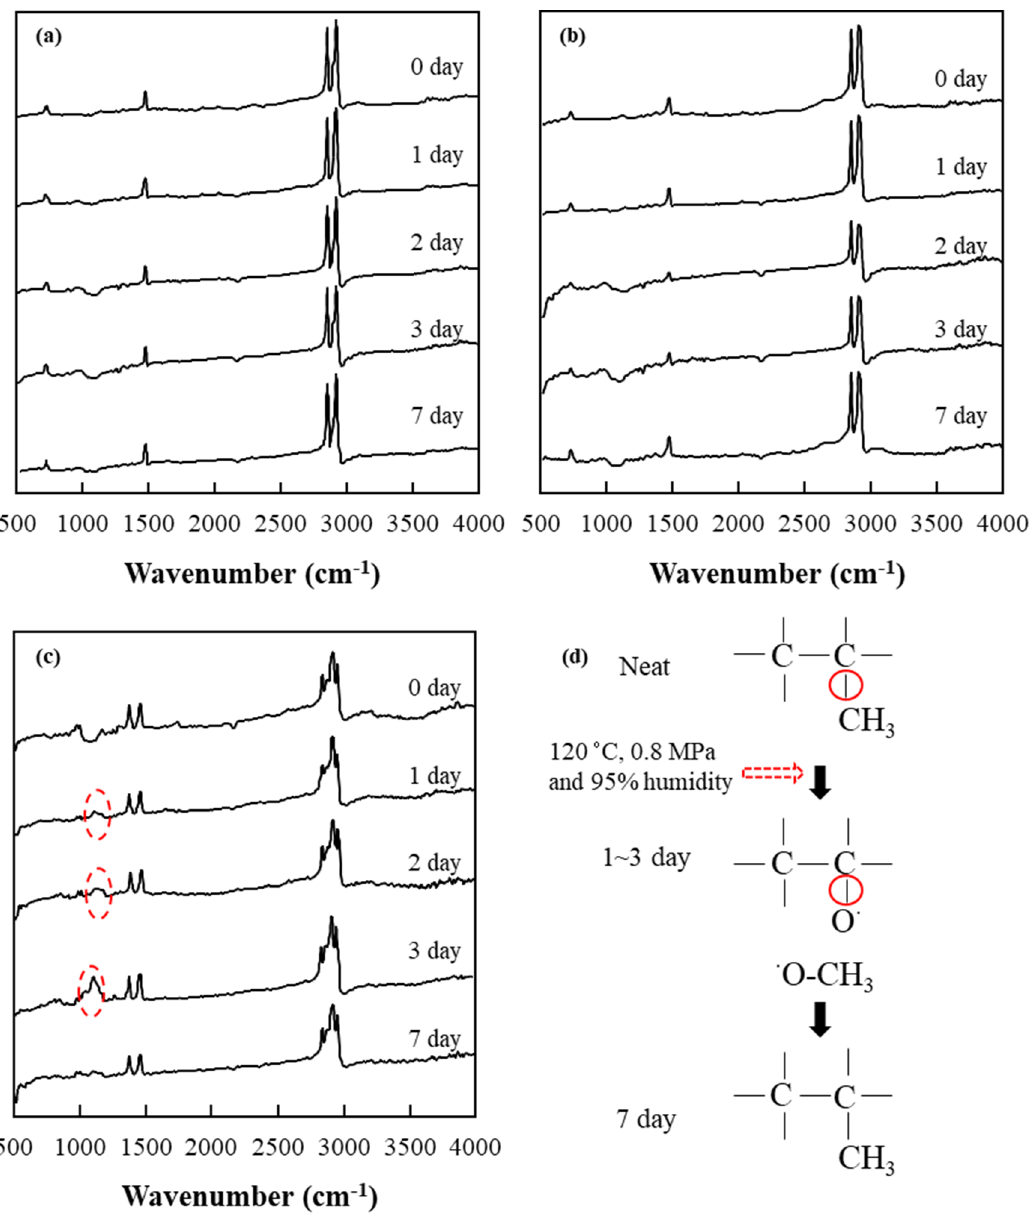
Figure 7. ATR-FTIR spectra of ( a ) HDPE, ( b ) LDPE, and ( c ) PP, and ( d ) a schematic expression of chemical reactions in PP according to aging days.